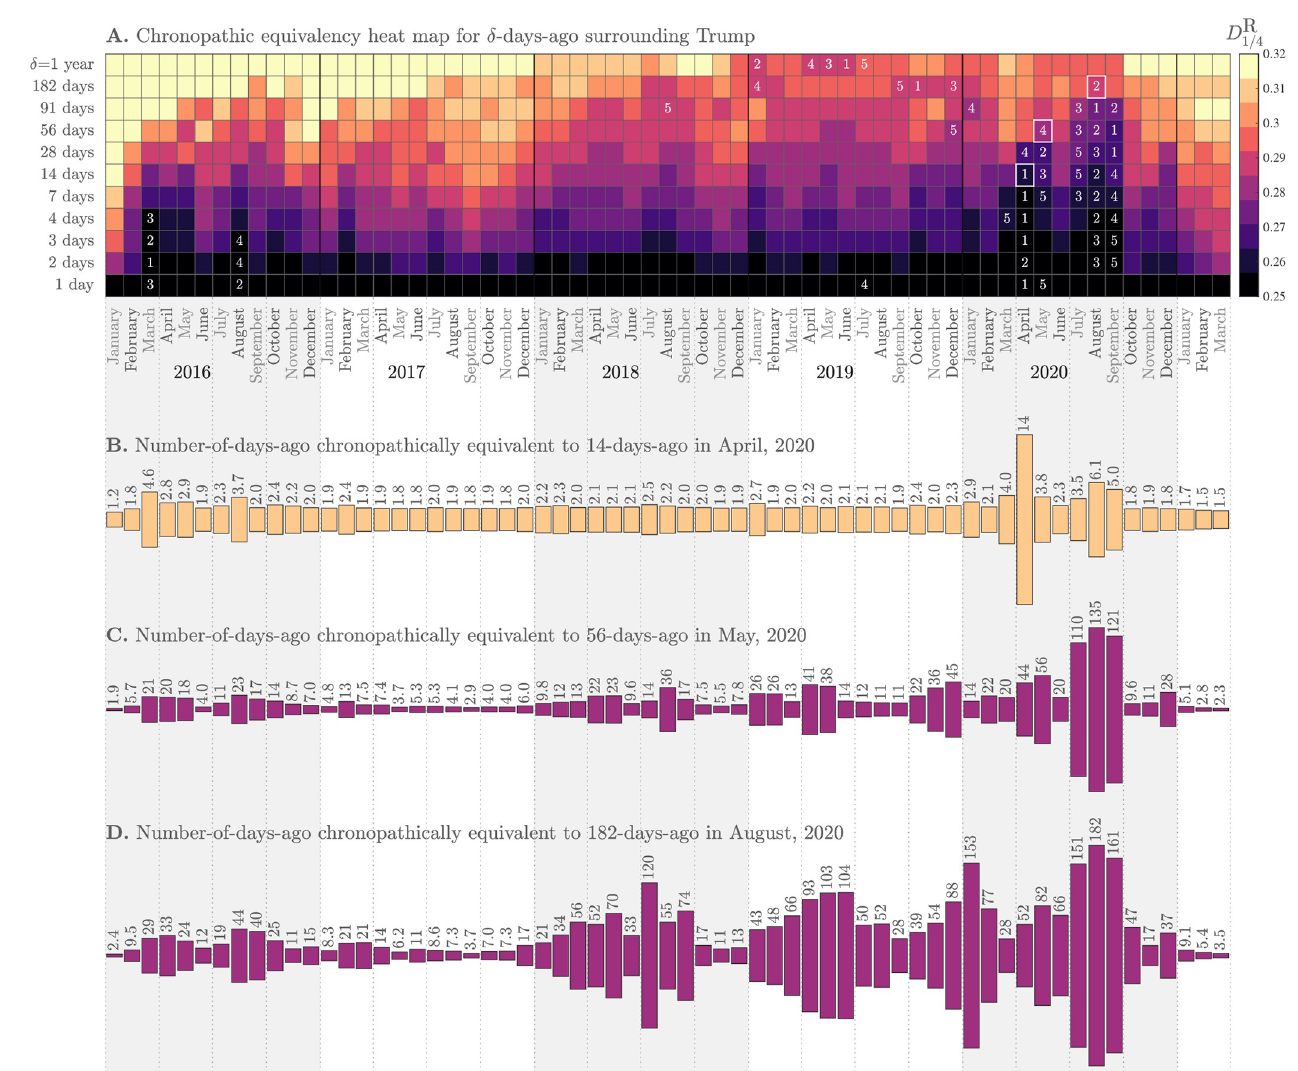
Fig 4. A. Chronopathic equivalency heat map: Each cell represents the ‘story distance’ for a given month and a given number of δ days before . We measure story distance as the median rank-turbulence divergence (RTD) between the Zipf distributions of 1-grams used in Trump-matching tweets for each day of a month and δ days before (we use RTD parameter α = 1/4). Lighter colors on the perceptually uniform color map correspond to higher levels of story turnover. Numbers indicate the slowest five months for each value of δ . After the story turbulence of the 2016 election year and especially the first year of Trump’s presidency, there has been a general slowing down in story turnover at all time scales (the ‘plot thickens’). By September US of 2020, the COVID-19 pandemic had induced record slowing down of story turnover around Trump at time scales up to 91 days, the story being punctuated by and then combined with the Black Lives Matter protests in response to George Floyd’s murder on May 25, 2020. B . Using an example anchor of April 2020 and δ = 14 days (white square in panel A ), a plot of chronopathic equivalent values of δ across time. During Trump’s presidency, the same story turnover occurred as fast as every 1.8 days in September 2017 and 1.7 days in October 2020. Because story turbulence is nonlinear, using a different anchor month and δ (i.e., selecting a different cell in the heatmap) potentially gives a different chronopathic equivalency plot. C . Anchor of 56 days in May 2020. D . Anchor of 182 days in August 2020. See the Online Appendices (compstorylab.org/trumpstoryturbulence/) for the most recent version of this figure. As for Fig 3, shading and lines give guides for years and quarters.